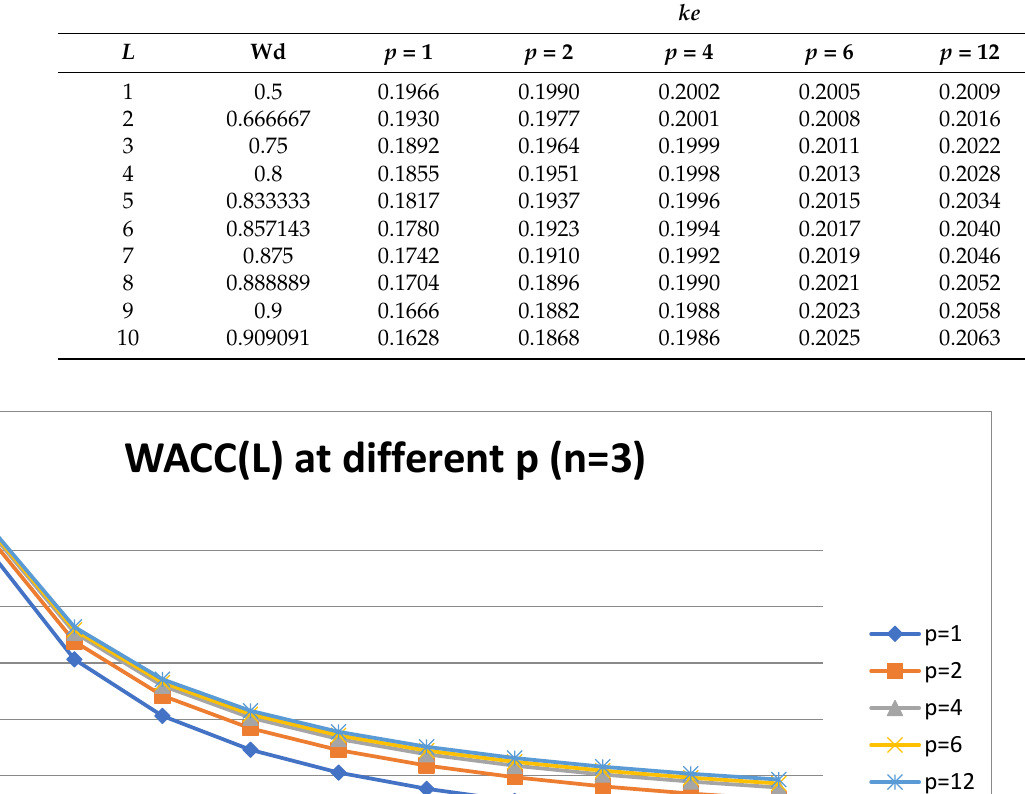
Figure 2. The dependence of the company value (V) on the leverage level (L) of a three-year-old company for advance profit tax payments with frequencies of p = 1, 2, 4, 6 and 12. As can be seen from Figure 3, the equity cost ( ke ) depended on the leverage level in a linear manner. It was not expected for ke (L) to be linear because the BFO equation for the WACC was an n + 1 power equation. However, as can be seen from the figures and tables for the equity cost results, this occurred with a high accuracy. We called the rela- tionship quasi-linear (or practically linear). Our entire extensive database showed that this was the case. The equity cost decreased for annual ( p = 1), semi-annual ( p = 2) and